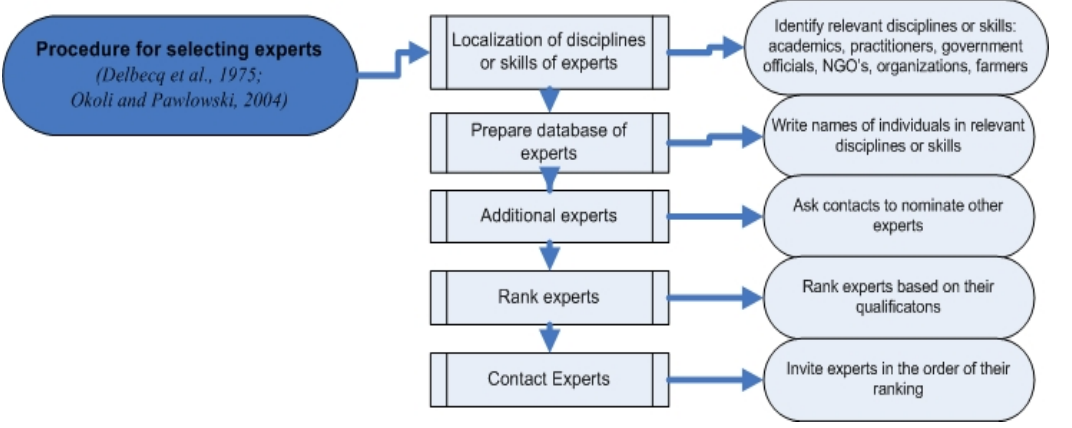
Figure 1. Procedure for selecting experts.